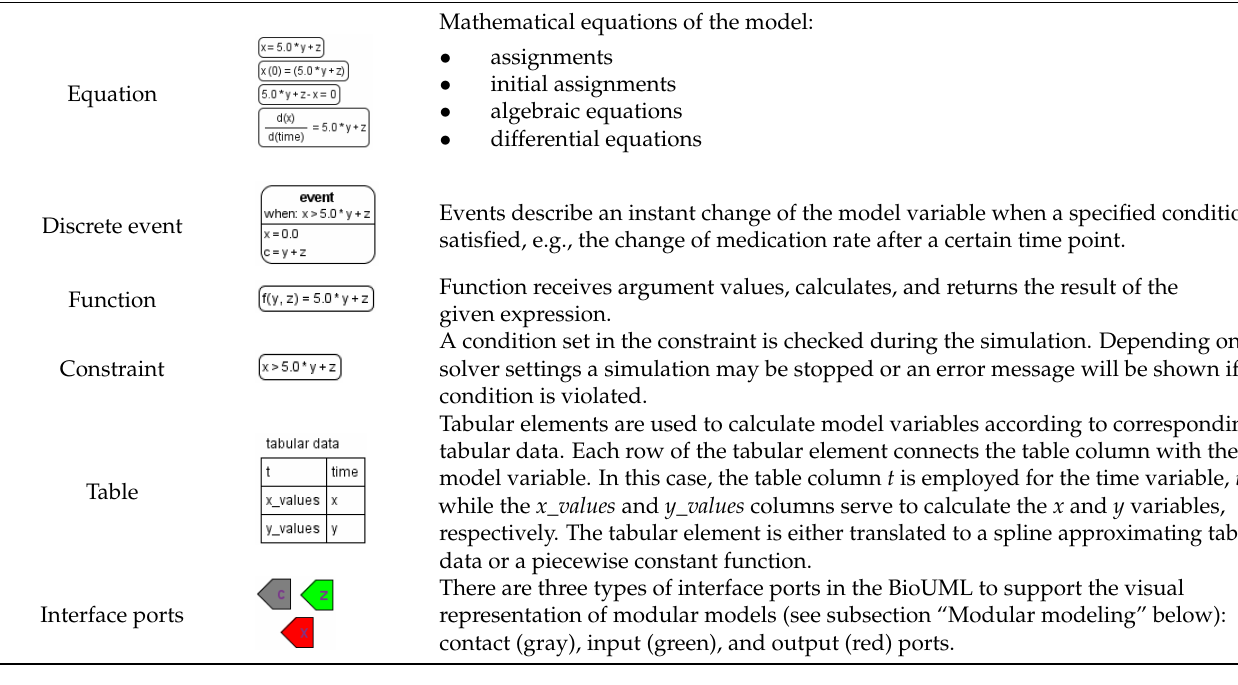
Table 2. Extension of Systems Biology Graphical Notation (SBGN) in BioUML for representation of the model elements. Adapted from https://doi.org/10.3390/ijms221910353 accessed on 1 April 2022. Element Name Glyph Description Mathematical equations of the model: